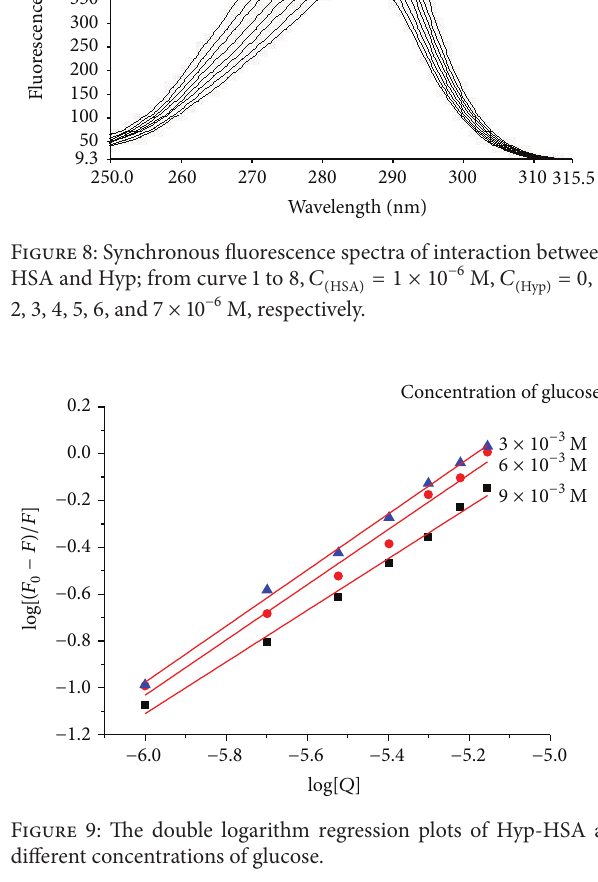
Figure 9: The double logarithm regression plots of Hyp-HSA at different concentrations of